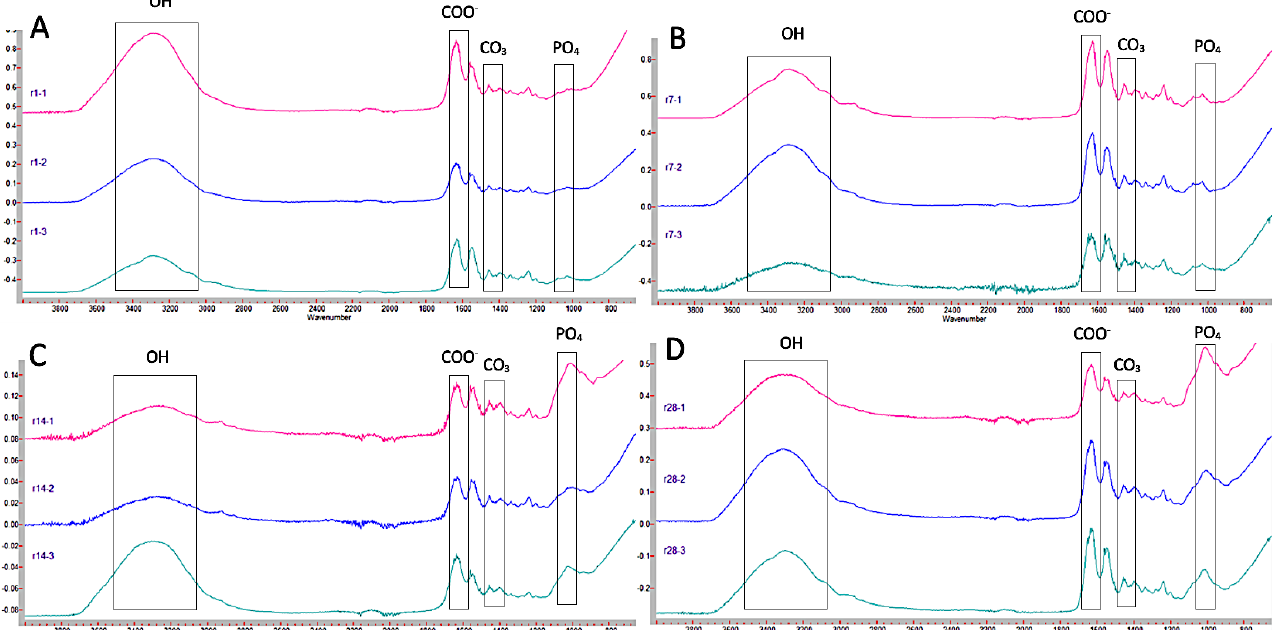
Figure 5. Comparison of Equia Forte FTIR spectra at different thicknesses (1, 2, and 3 mm) at 24 h ( A ), 7 days ( B ), 14 days ( C ), and 28 days ( D ). The peaks of the OH, COO − , CO 3 , and PO 4 groups of interest in this study are indicated.